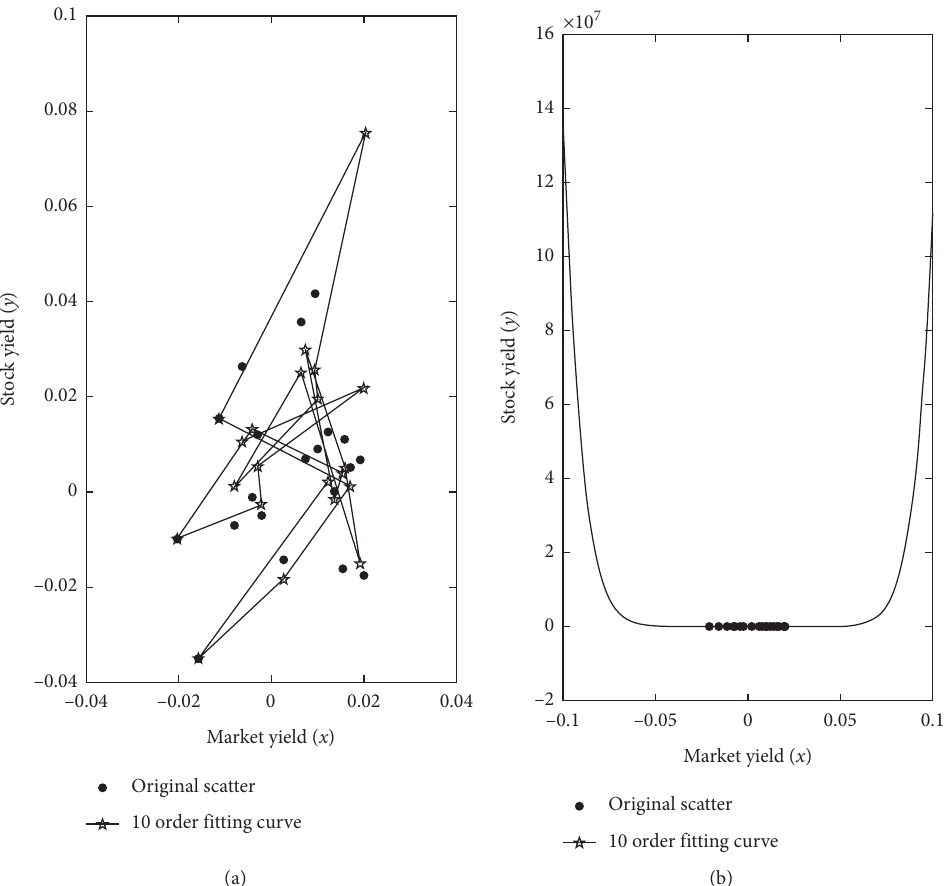
Figure 5: High-order polynomial model fitting map. (a) Original scatter VS predicted points. (b) High-order polynomial fittings.